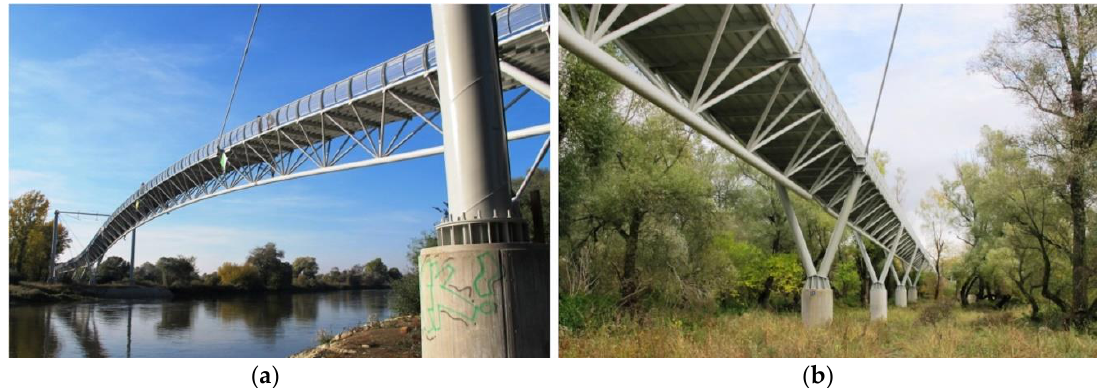
Figure 5. The Liberty Bridge: ( a ) suspended structure; ( b ) inundation bridge.